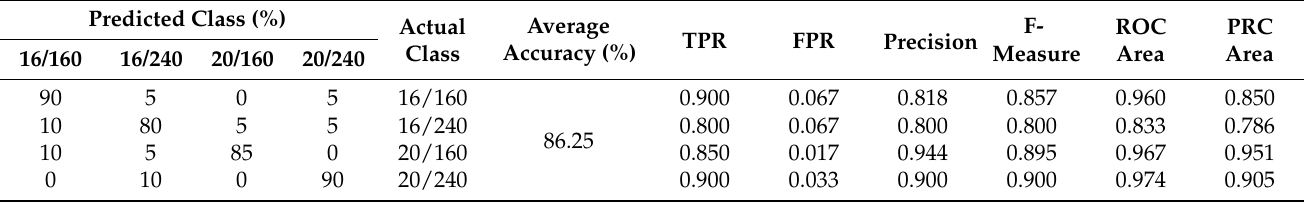
Table 3. The discrimination metrics of leaves of cv. ‘Elizium’ romaine lettuce grown under different light environments (photoperiod 16 and 20 h and PPFD 160 and 240 µmol m − 2 s − 1 ) for the model built based on image textures from all color channels using the Multilayer Perceptron machine learning algorithm.